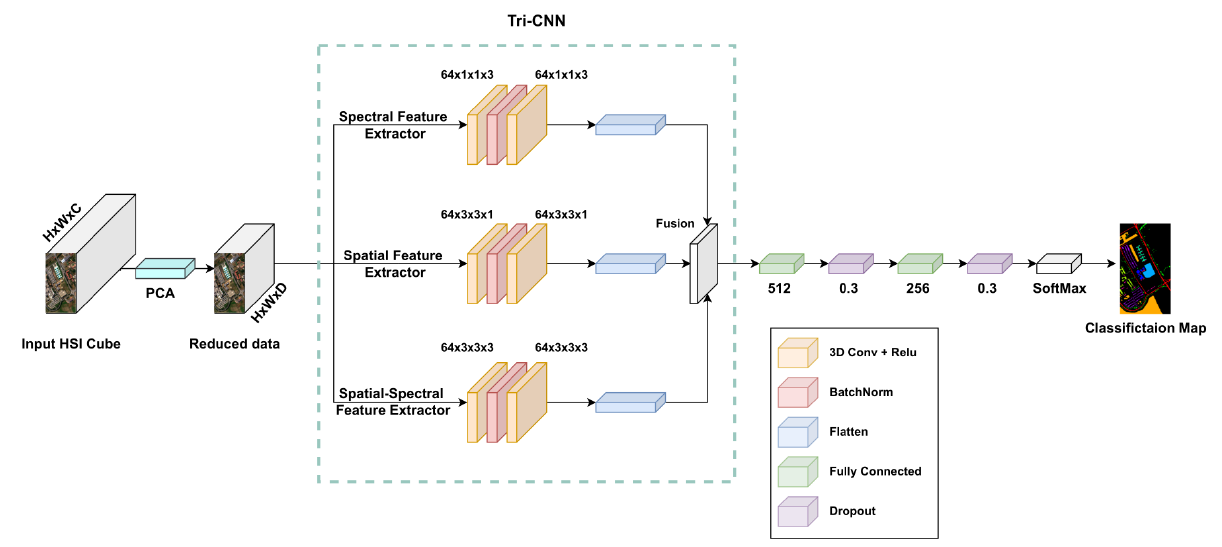
Figure 1. Framework of the proposed